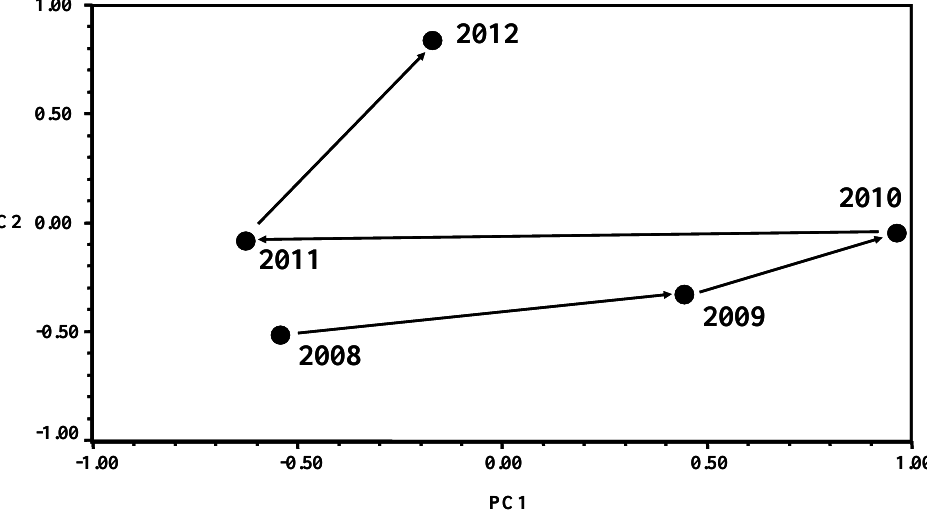
Figure 1. Results of Principal Component Analysis (PCA) showing the trend in the bacterial contamination of meals and surfaces sampled from 2008 to 2012 at the University